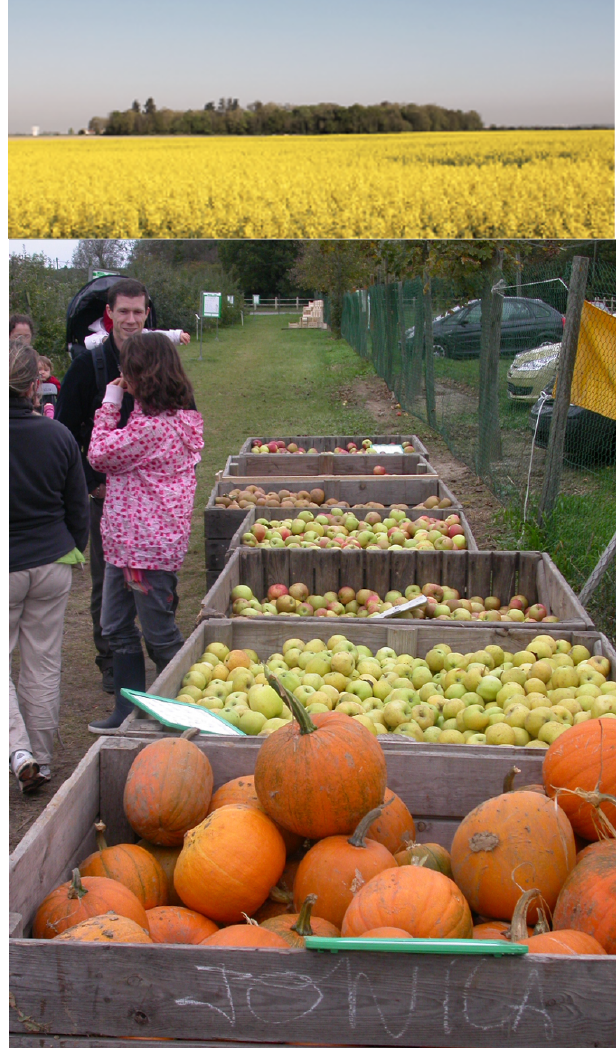
Figure 4. “The Plateau de Saclay”, near Versailles (France), rapeseed crops and orchards.